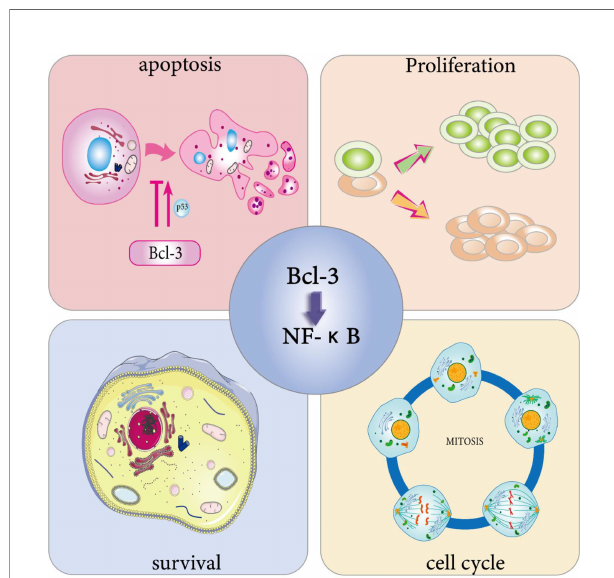
FIGURE 2 | Physiological effects of Bcl-3. Bcl-3 is able to participate in cell cycle regulation. On the one hand, it can directly trigger cell division through the activation of cell cycle protein D, thus promoting cell proliferation, and on the other hand, the overexpression of Bcl-3 slows down T cell proliferation at an early stage during the T cell response to antigen. Bcl-3 has been shown to be a survival gene. In immune cells, activated T cells overexpressing Bcl-3 showed increased survival, while T cells lacking Bcl-3 died abnormally. Bcl-3 has been widely de fi ned as an anti-apoptotic gene. One of its anti-apoptotic pathways involves p53 regulation. However, in survival studies of multiple myeloma (MM) cells, overexpression of Bcl-3 increased apoptosis. The cell characteristics that determine whether Bcl-3 promotes or inhibits the transcription of NF- k B- dependent antiapoptotic genes still need to be identi fi